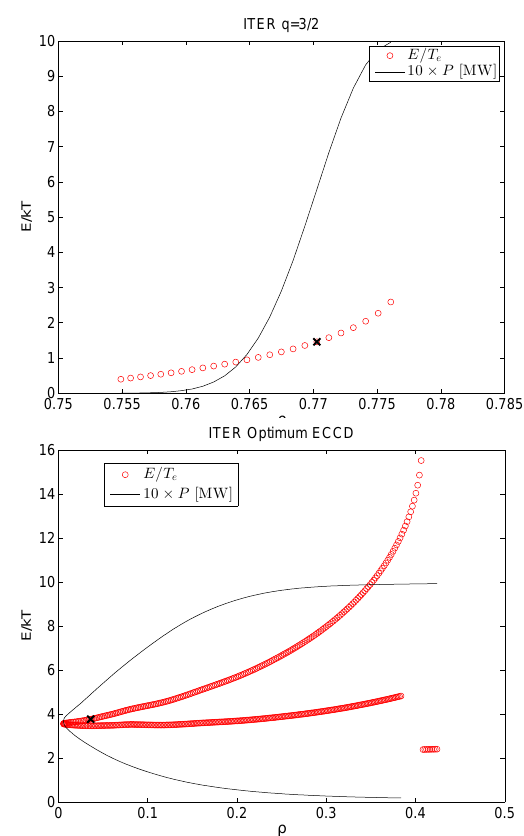
Figure 2. Comparison of the energy of the resonant electrons (calculated as E = mc 2 ( γ − 1) with γ = 1 + u 2 , see text), k− normalized to the electron temperature, for a standard ITER situ- q ation (deposition on the q = 3 / 2-surface, injected frequency 170 GHz, launch position ( R , Z ) = (705 . 4 , 417 . 8) cm, toroidal injec- tion angle β = 20 ◦ , left panel) and an ITER high-CD scenario (central deposition, injected frequency 210 GHz, launch position ( R , Z ) = (810 , 320) cm, toroidal injection angle β = 37 ◦ , right panel). The black crosses denote the position of maximum ab- sorption. Also shown is the power carried by the beam, multi- plied by 10 for the ease of comparison (black